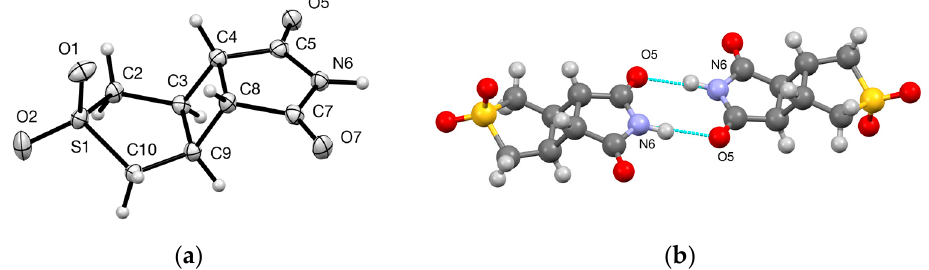
Figure 3. ( a ) Molecular structure of 1 with numbering system used (50% thermal ellipsoids), ( b ) hydrogen bonding pattern for 1 . Table 4. Hydrogen bonding parameters (Å, ° ).